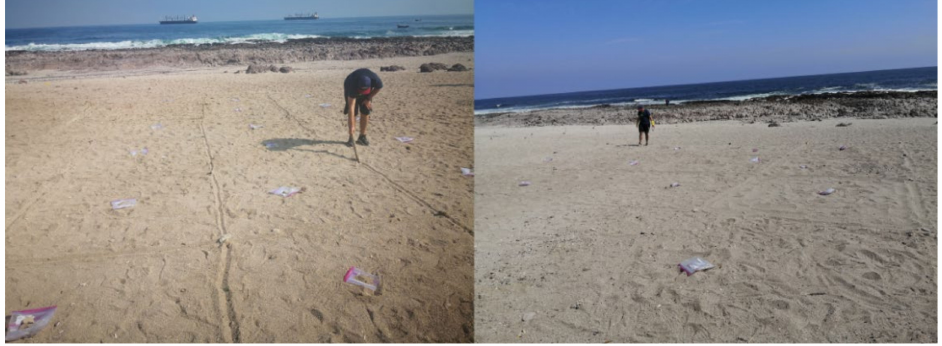
Figure 3. Sample